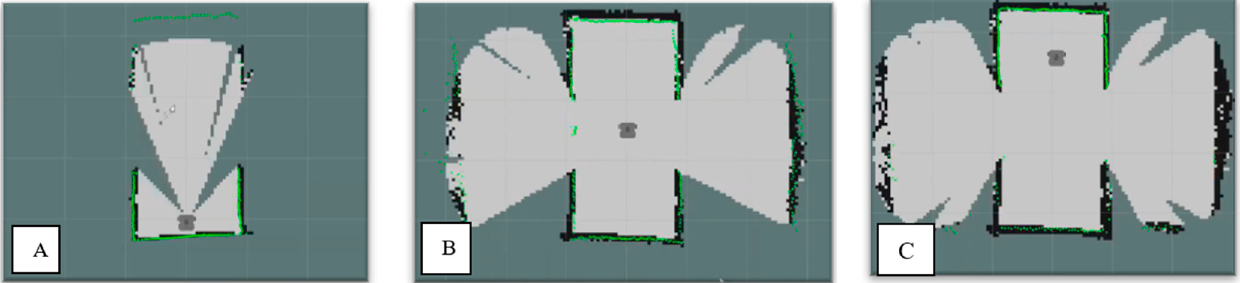
Figure 10. RViz map of test case 3 at positions ( A – C ) where the mobile robot travels between two parallel plane mirrors.